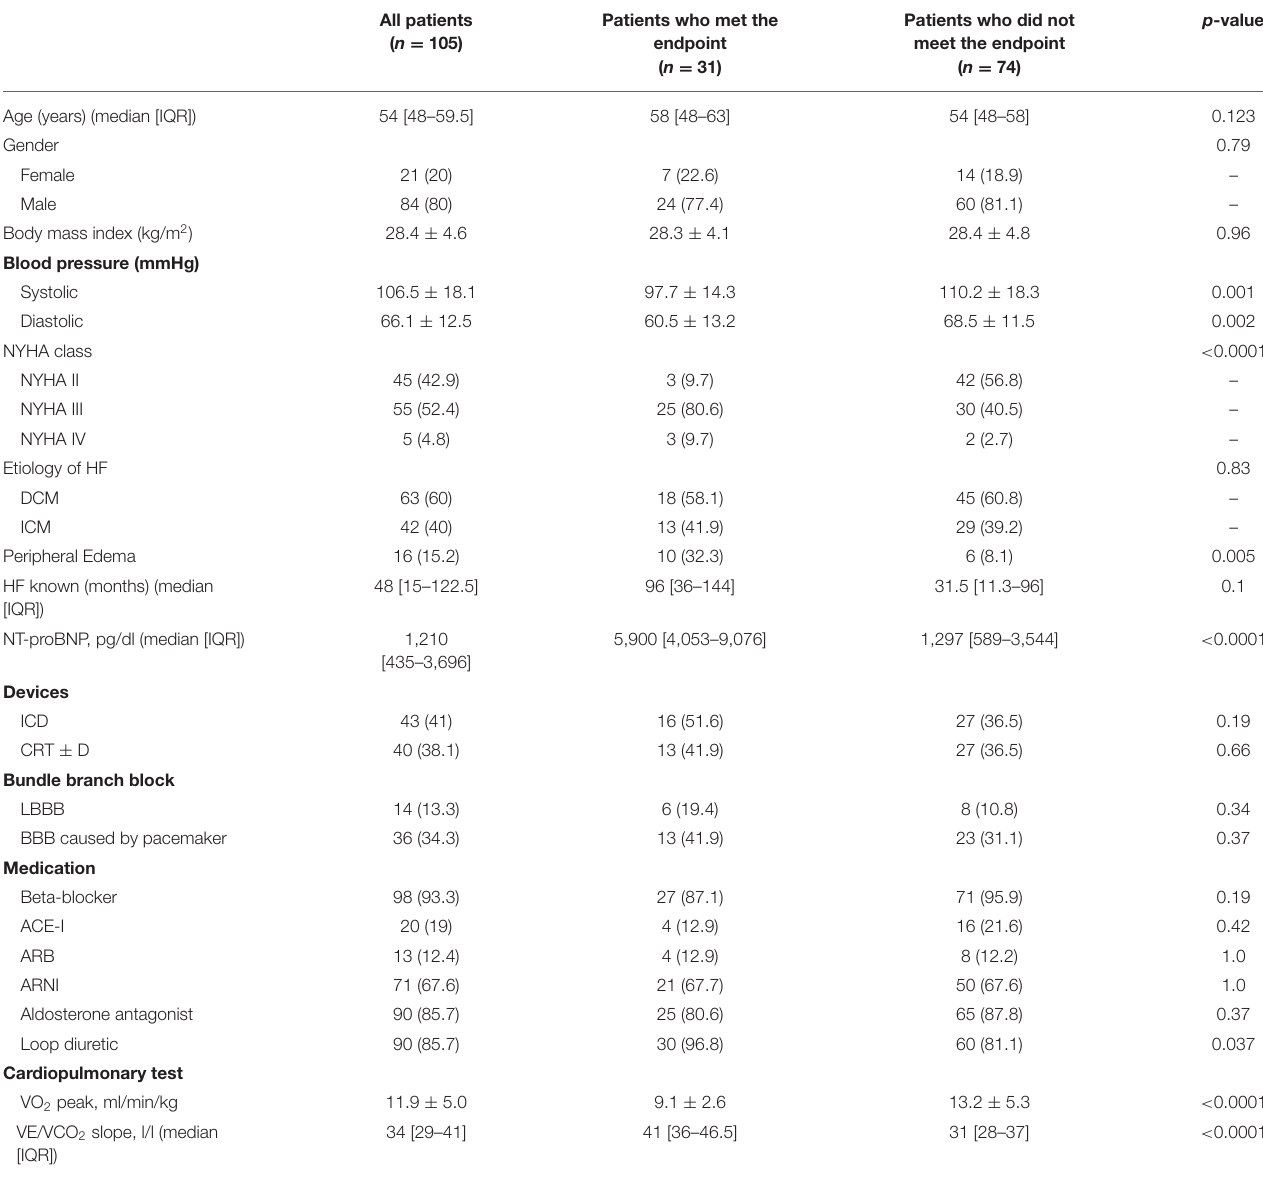
TABLE 1 | Clinical and demographic characteristics at baseline.